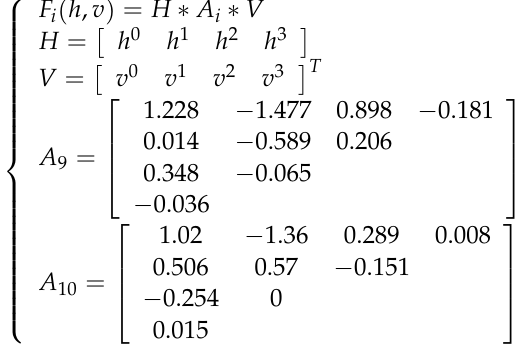
Figure 11, the distance from the center of the circle under each group of flight parameters was averaged and the function of the distance from the center of the circle was fitted. F 9 and F 10 represent the trend function under downwind and upwind conditions, respectively, that is, the relation function of the degree of protrusion of the model: 